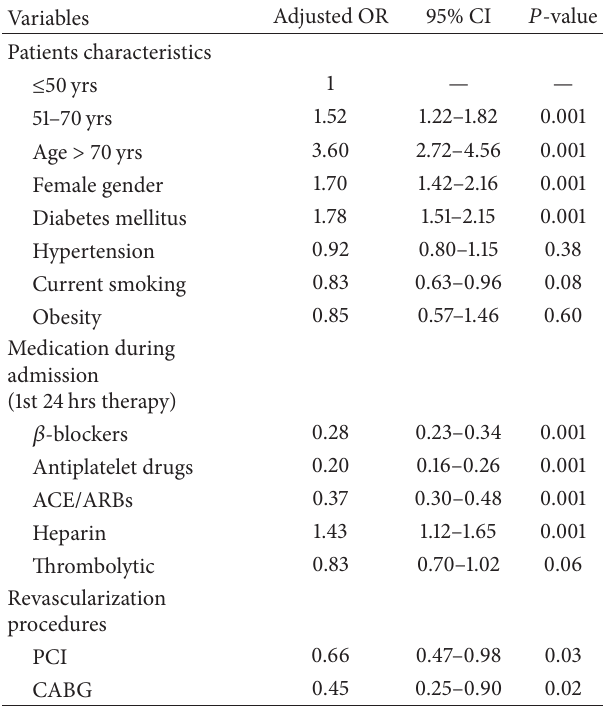
Table 3: Multivariate regression analysis for predictors of in- hospital